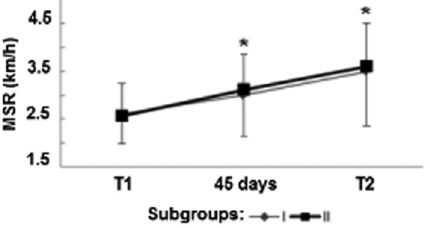
Figure 3. Mean speed rate (MSR) training progressions (km/h) for subgroups I and II during the study period. T1: 3 months after study initiation, T2: 6 months after study initiation. *P=0.001, T1 compared to 45-days; 45-days compared o T2; T1 compared to T2 for the two subgroups